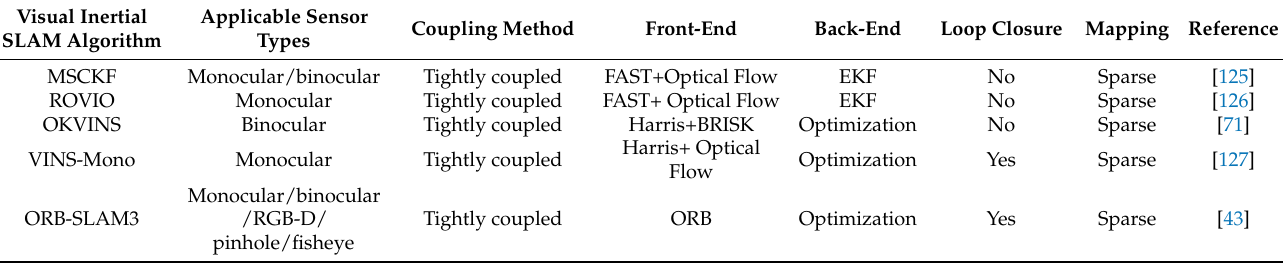
Table 7. Commonly used feature extraction algorithms in